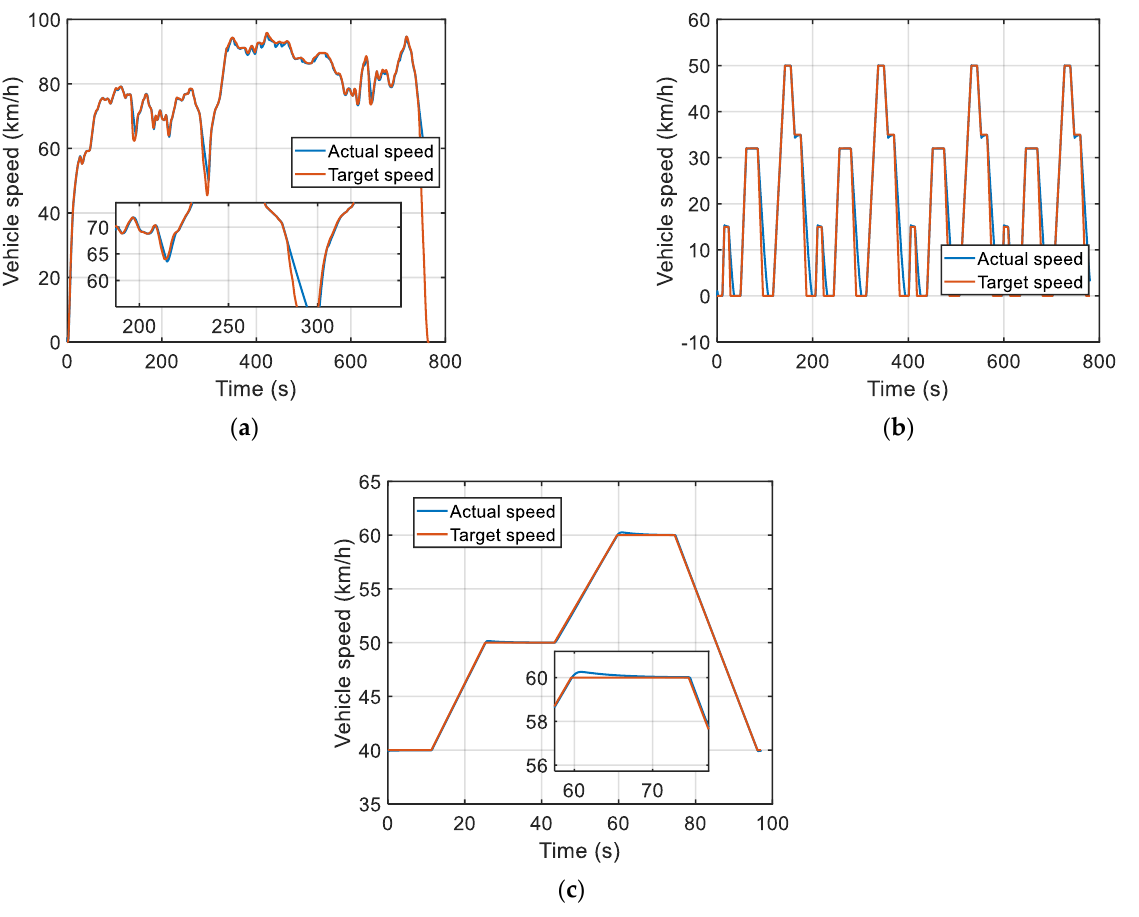
Figure 11. Simulation results of EPA suburban cycle for pickup. ( a ) EPA cycle; ( b ) NEDC; ( c ) 6-mode cycle.